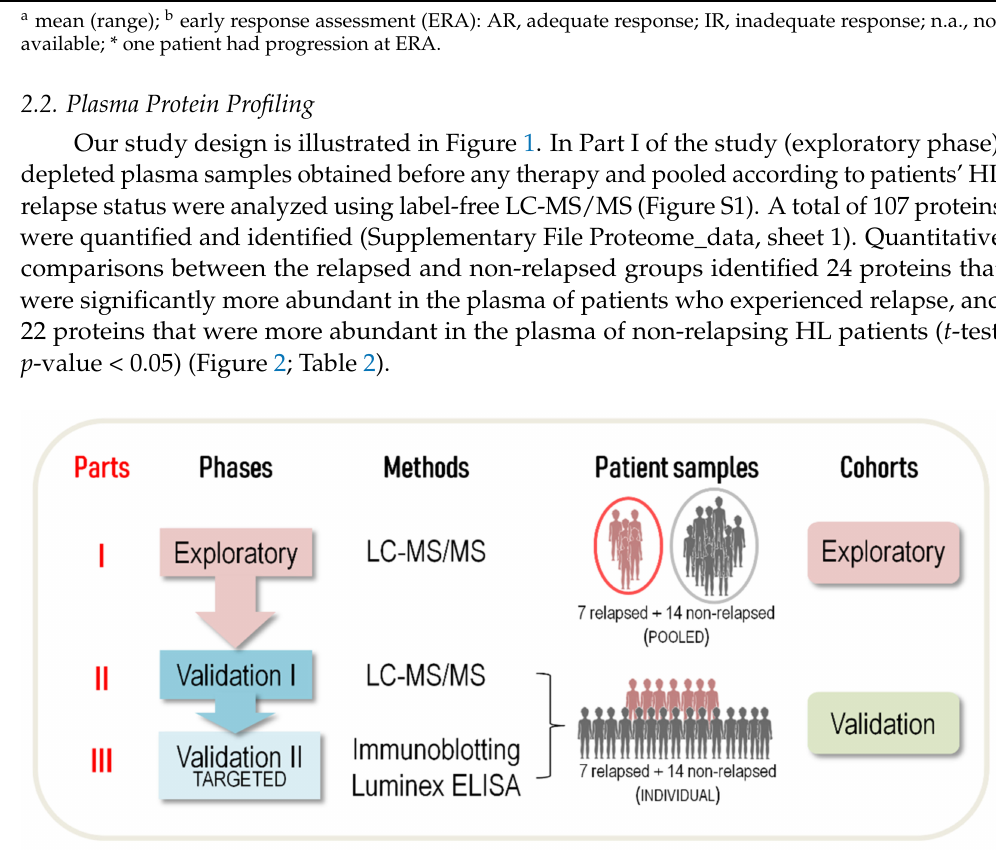
Figure 1. The three parts of our experimental workflow. LC-MS/MS, label-free quantitative liquid chromatography-tandem mass spectrometry; ELISA, enzyme-linked immunosorbent